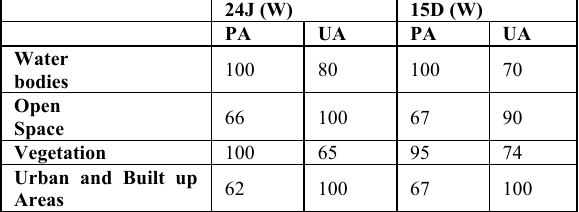
Table 3: Accuracy Assessment; PA: Producer's Accuracy; UA: User's Accuracy; 24J: 24th July; 15D: 15th December; (W): Wishart H-A- Alpha classified